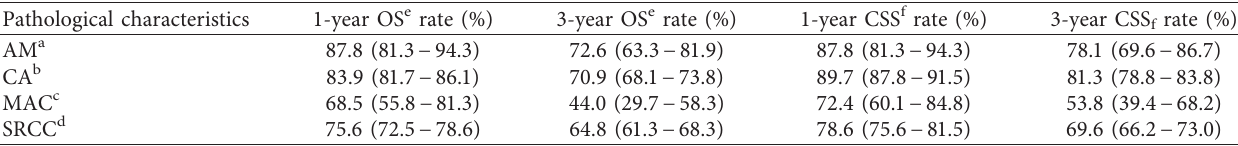
Table 3: 1-year and 3-year overall survival (OS) rates and cancer-specific survival (CSS) rates of patients with 4 histological subtypes (adenocarcinoma with mixed subtypes, classical adenocarcinoma, mucinous adenocarcinoma, and signet-ring cell carcinoma) in early gastric cancer.